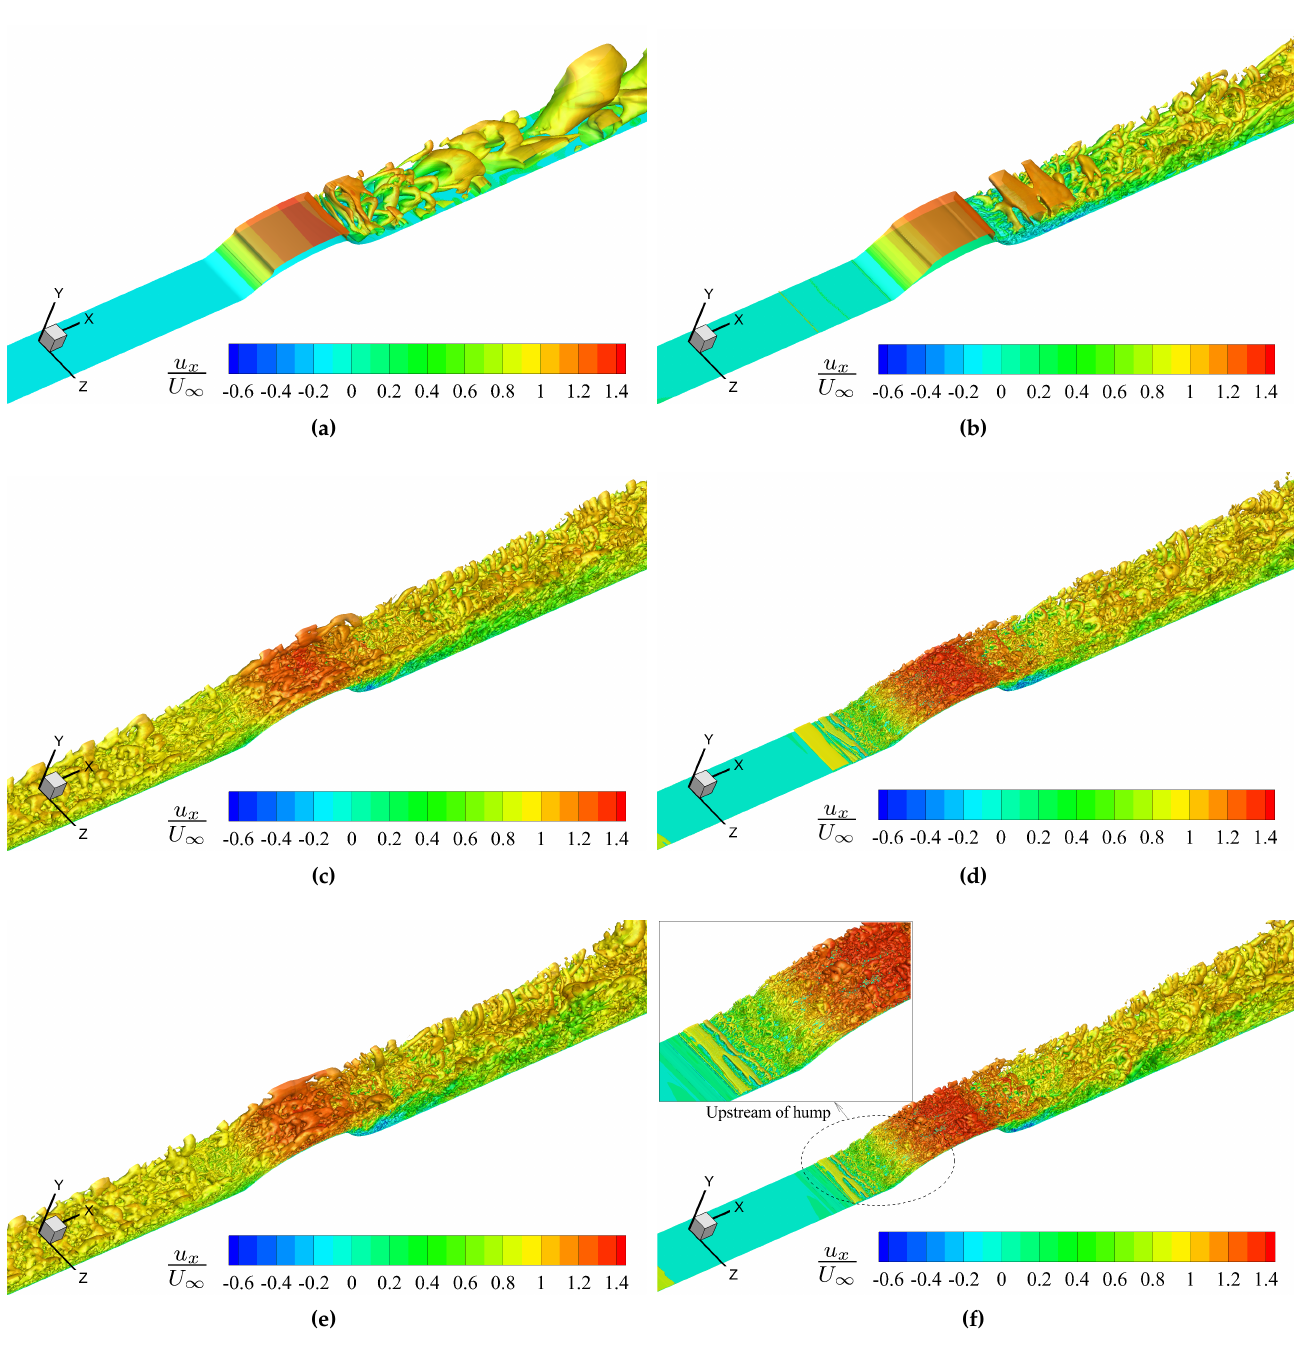
Figure 11. Transient vortex structures visualized by iso-surface of Q -criterion colored by streamwise velocity obtained by: ( a ) SST-DES based on NASAMesh, ( b ) SST-DES based on NewMesh, ( c ) SA- DES with turbulent inflow, ( d ) SA-DES with laminar inflow, ( e ) WMLES with turbulent inflow and ( f ) WMLES with laminar inflow, where ( c – f ) are based on